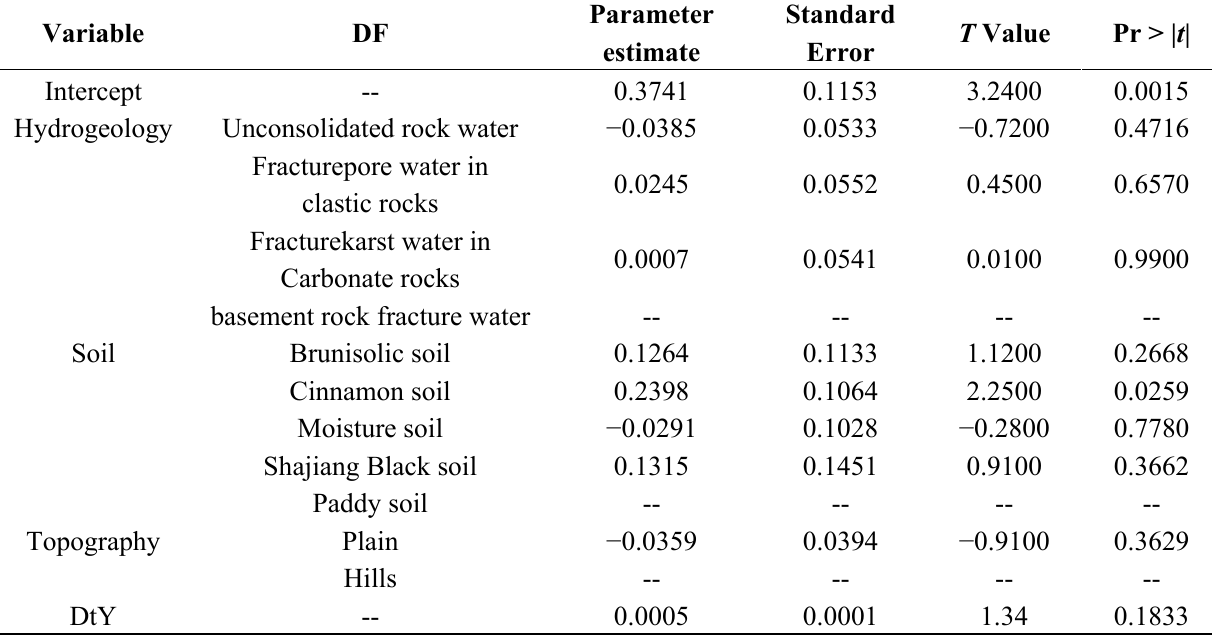
Table 3. Parameter estimates of